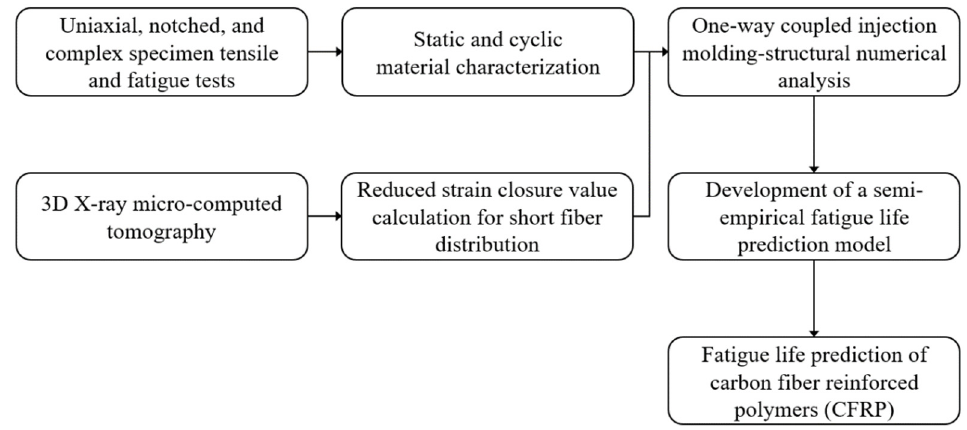
Figure 1. The procedure of fatigue life prediction for CFRP.